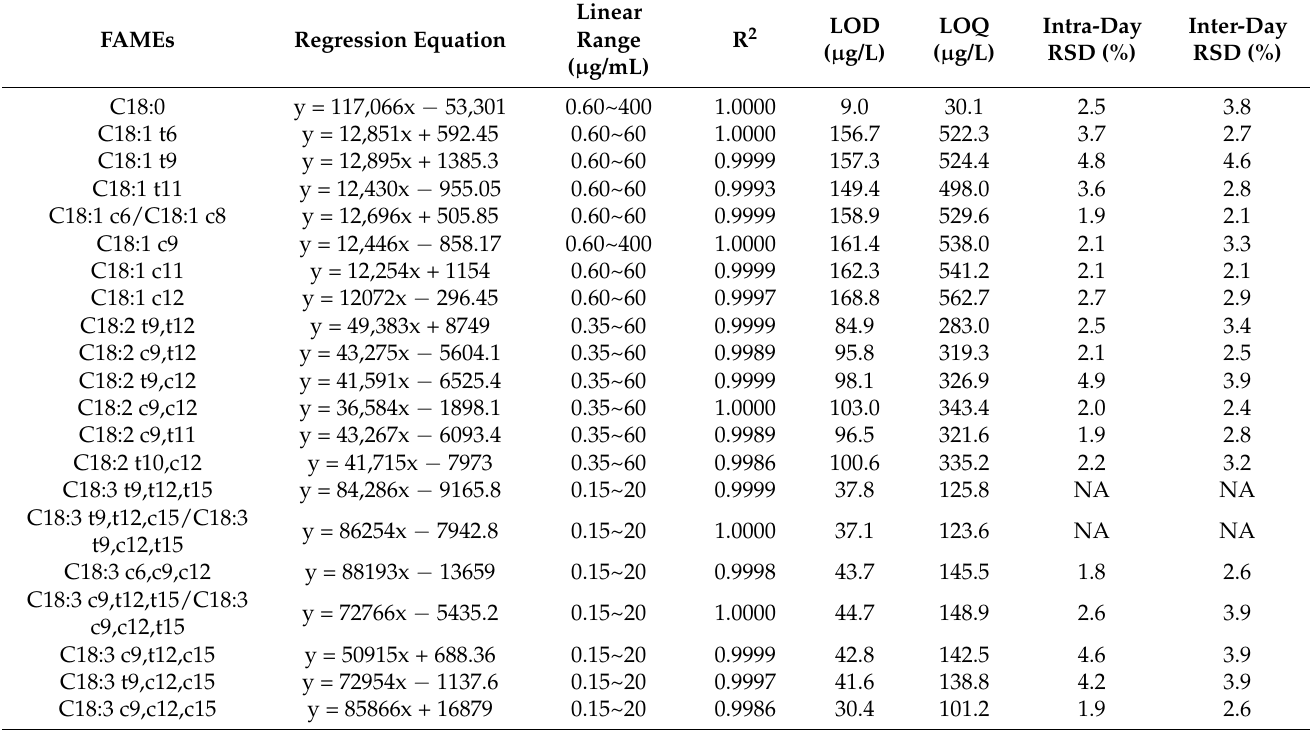
Table 2. Linearity, sensitivity, and precision of the proposed method.